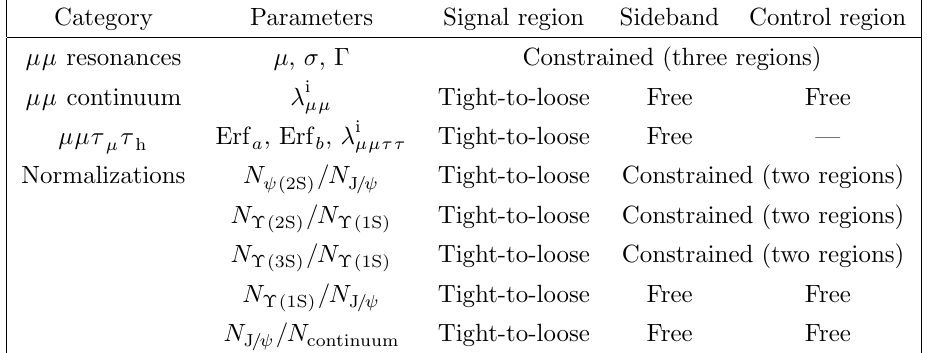
(cid:28) (cid:22) h